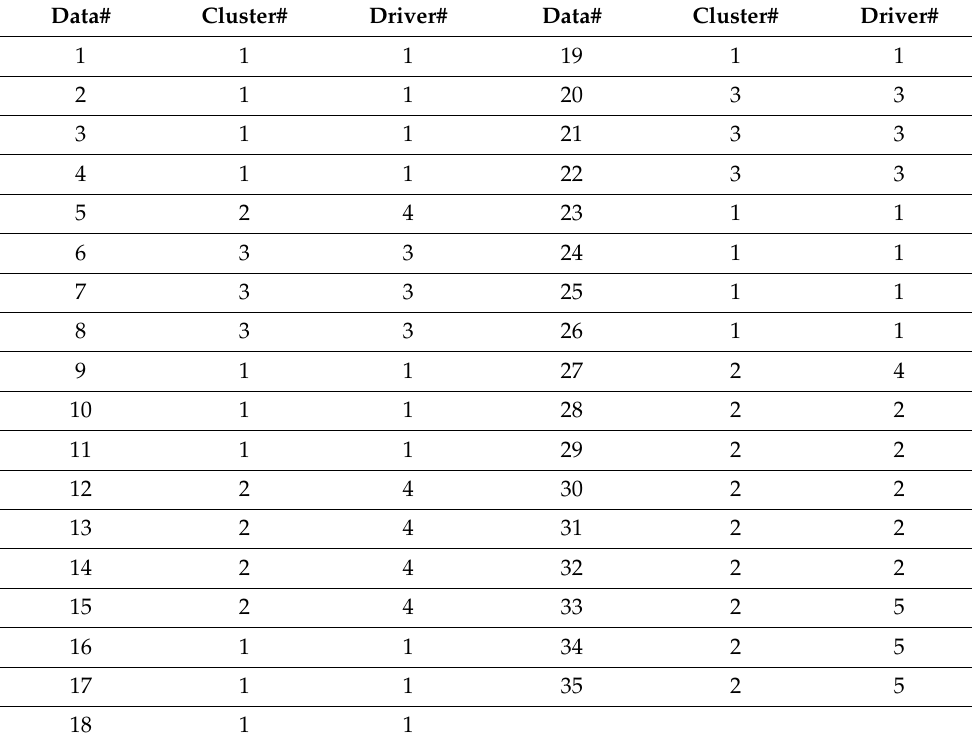
Table 7. Log of cluster assignment and driver identification number with probability threshold set at